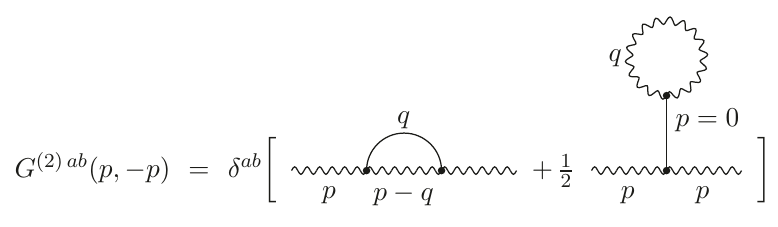
Figure 3 . The diagrams for the two-point function in the momentum